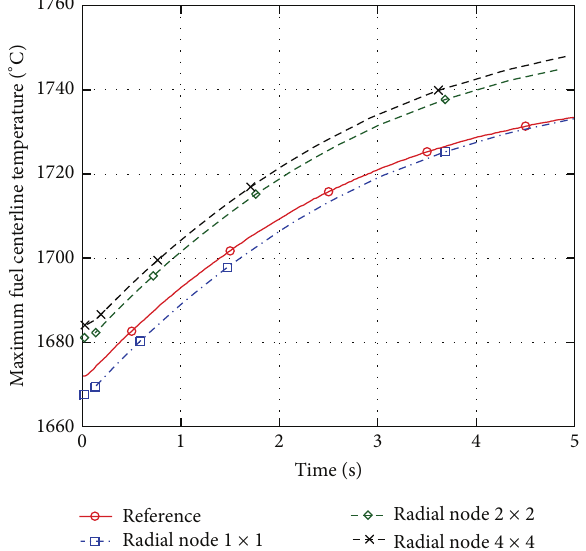
Figure 8: Effect of axial layer size on the power peak for case